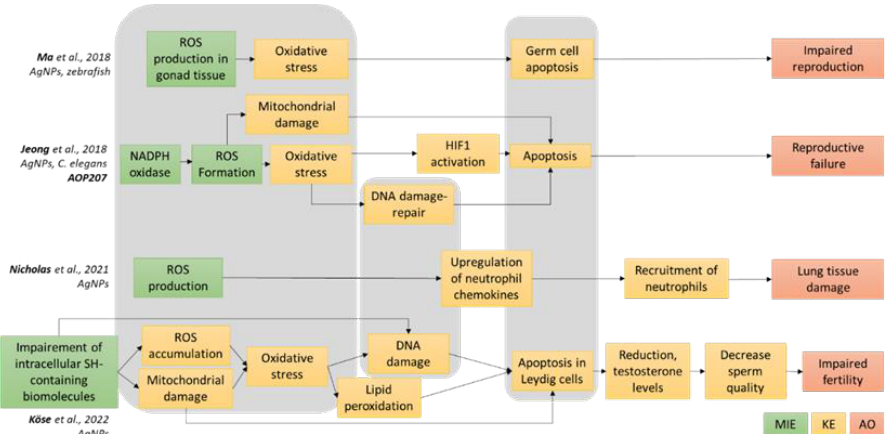
Figure 1. AOPs reporting Ag NPs as a potential stressor. Four AOPs showing Ag NPs as stressors were analyzed in terms of their molecular initiating events (MIE, green boxes), key events (KE, yellow boxes) and adverse outcomes (AO, orange boxes) [38–41]. This led to the identification of several pathways that are shared among these AOPs (highlighted in grey), focusing on oxidative stress, DNA damage and repair, and apoptosis. These pathways served as the basis of our AOP-oriented Ag NP toxicity-testing strategy.